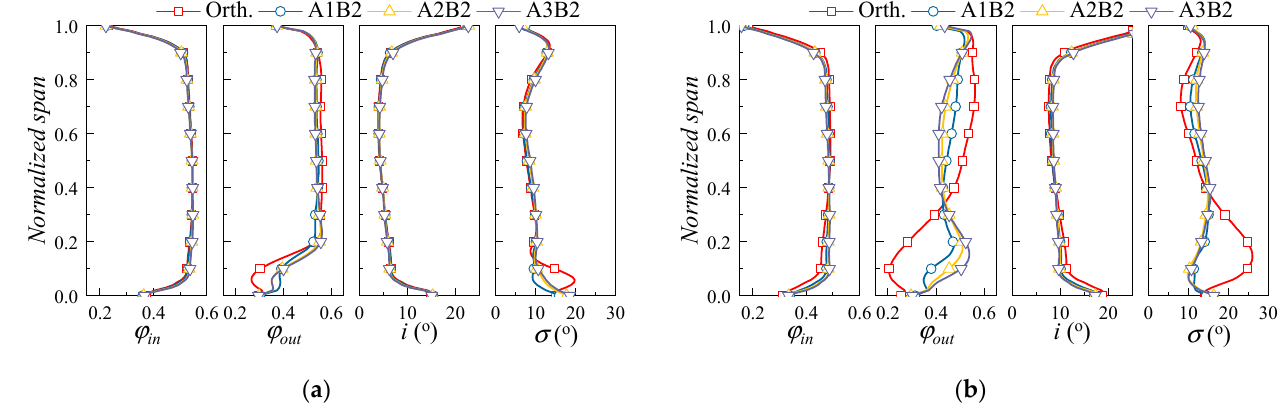
Figure 7. Radial distribution of aerodynamic performance for the cases with different sweep heights. ( a ) φ = 0.52; ( b ) φ = 0.46.